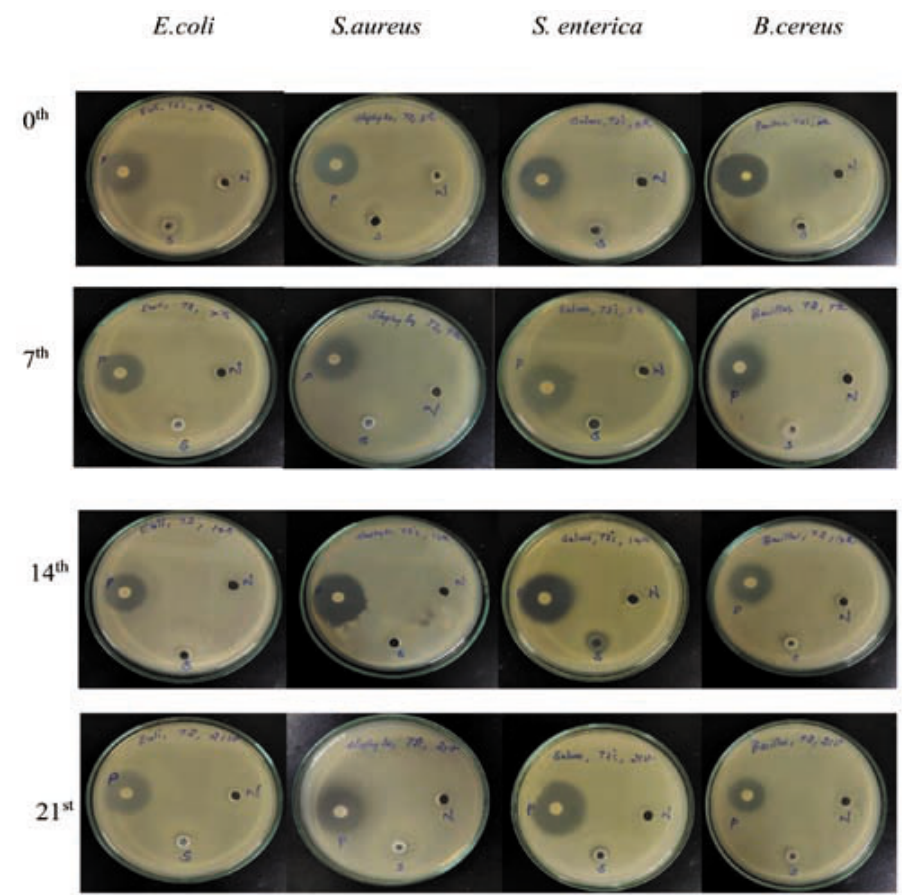
Fig.2. Antibacterial activity of the WSPE of fermented milk made from goat milk heated to 72°c/15sec against different pathogens during cold storage (inhibition zone in mm). P-positive control, N-negative control,